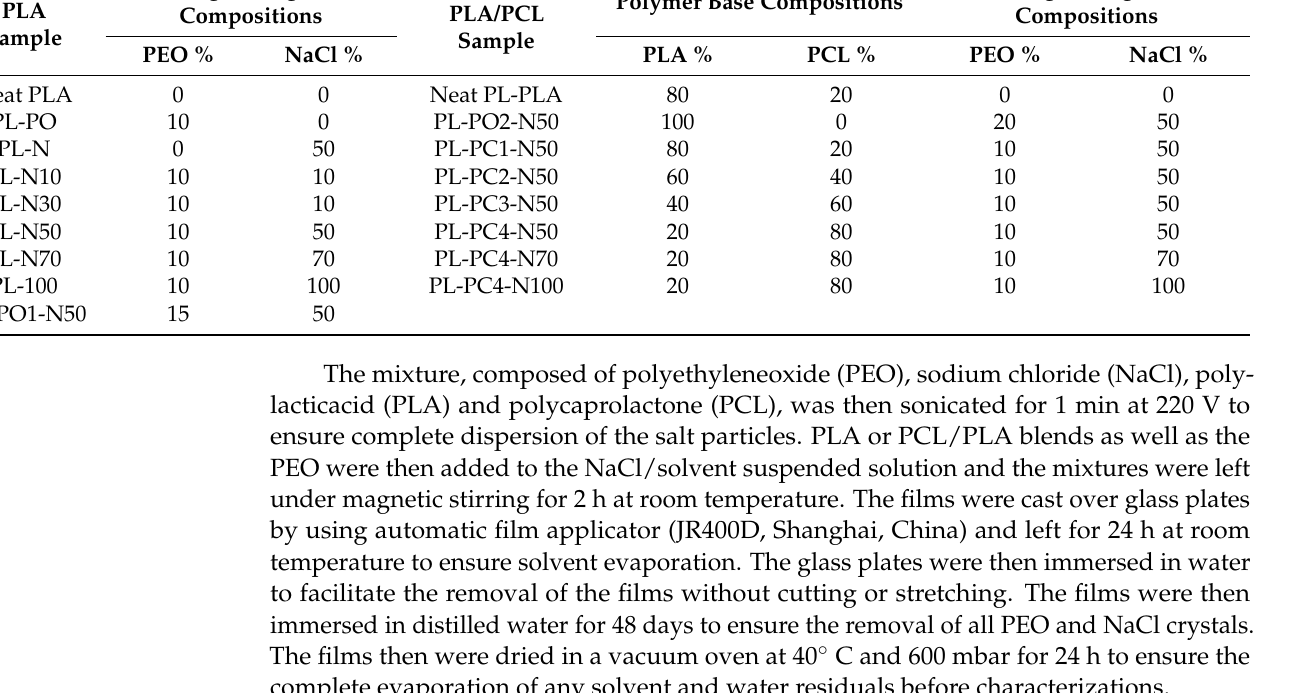
Table 2. Porous Poly (lactic acid) (PLA) and PLA/polycaprolactone (PCL) films with different porogenic concentrations.